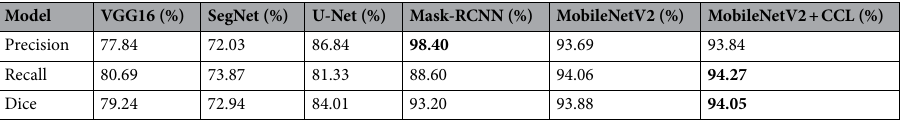
Table 2. The precision, recall, and dice score evaluated using various models on the Medetec dataset. Bold values indicate the best performance among the present models